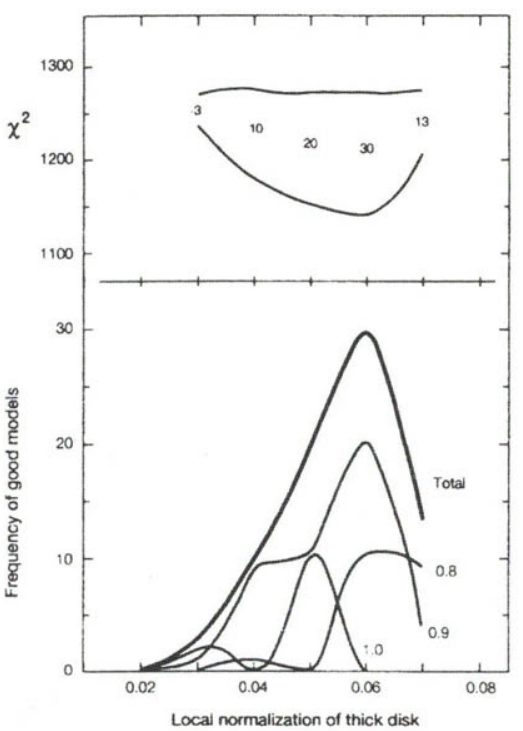
Fig. 9. Parameter coupling between the thick-disk local density nor- malization (abscissa) and the old thin-disk scale height (coded lines) for globally best models confined withip ^"boundaries shown in the upper